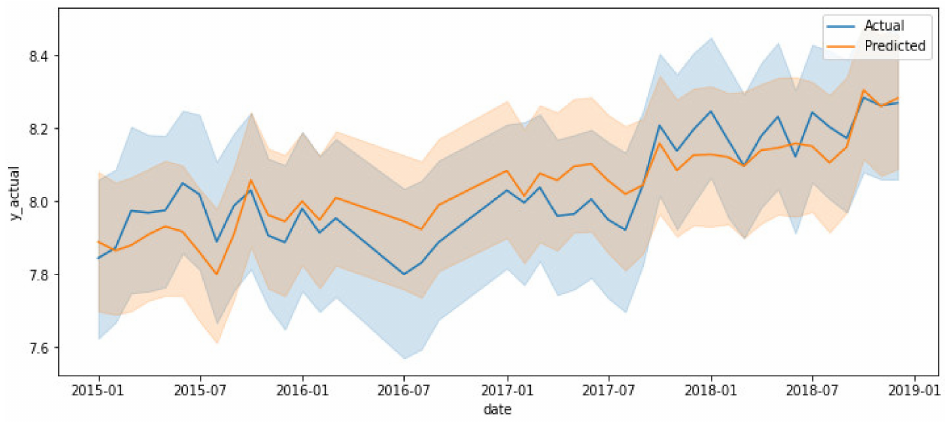
Figure 4. Linear Regression.